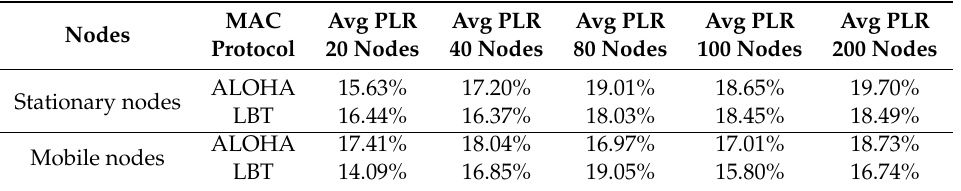
Table 5. Average PLR - Unconfirmed